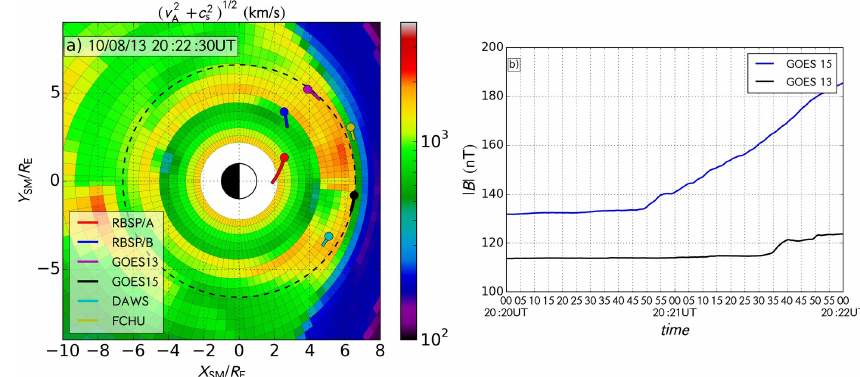
Figure 4. The color-coded logarithm of magnetosonic speed (panel a ) extracted from LFM simulation at SM equatorial plane at the time of shock arrival. Location of the Van Allen Probes, GOES 13 and 15 satellites, and CARISMA’s Dawson City and Fort Churchill magnetometer stations during 8 October 2013 at 20:22:30UT in the SM coordinate system. Panel (b) shows magnetic field measurement by GOES satellites around the shock arrival time. Timing analysis yields a propagation speed of 978kms − 1 from GOES 15 to GOES